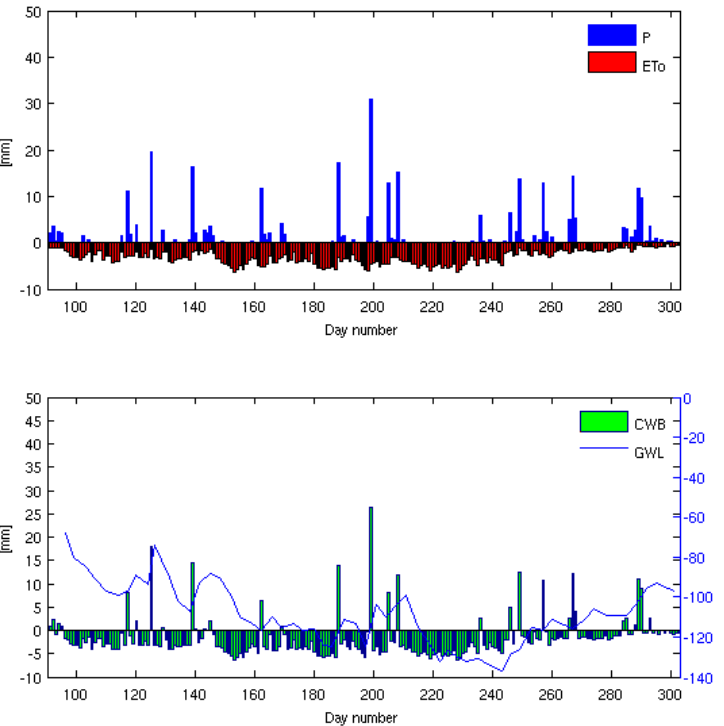
Figure 4. Variation of daily data of meteorological conditions during the vegetation season in the year 2015. P, precipitation; ETo, reference evapotranspiration; CWB, climatic water balance; GWL, ground water level.